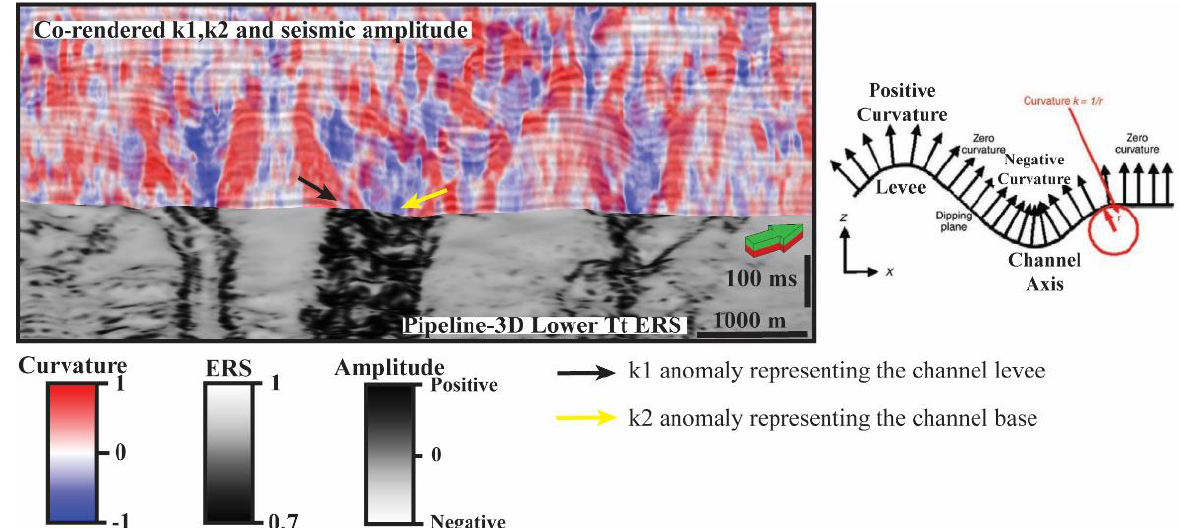
Figure 5. Co-rendered curvature (most positive and most negative) with seismic amplitude inline, displayed with the ERS attribute extracted along Lower Tt. The curvature attributes highlight concave-down (k1) and concave-up (k2) reflectors, while the ERS attribute highlights discontinuities caused by dipping planes.